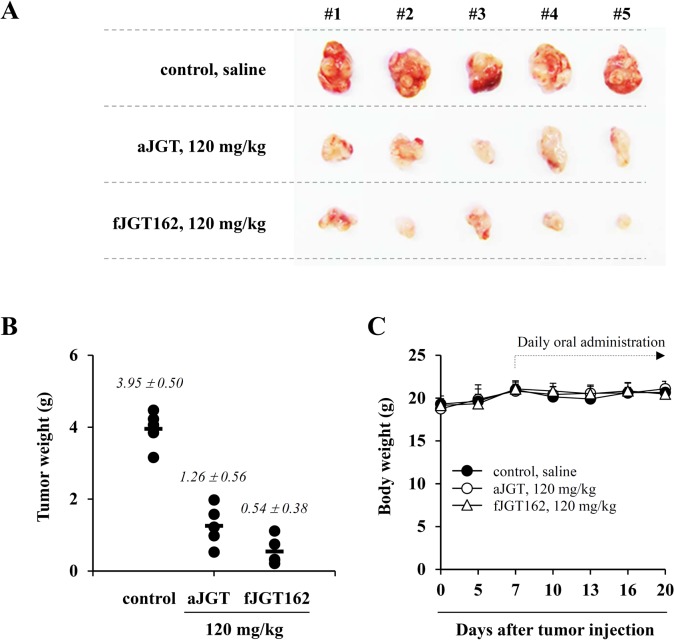
aJGT and fJGT162 suppress in vivo tumor growth in a xenograft model.
(A) HT1080 cells (2 × 106 /mouse in 200 μL PBS) were inoculated subcutaneously in BALB/c nude mice. After 7 days the mice were treated daily with saline (control), 120 mg/kg aJGT, or 120 mg/kg fJGT162 for 14 days. On day 21 after tumor inoculation, the tumors were removed and photographed. (B) The final tumor weight at the end of experiment was measured. (C) Body weight was measured during the experiment. Data are means ± SD.